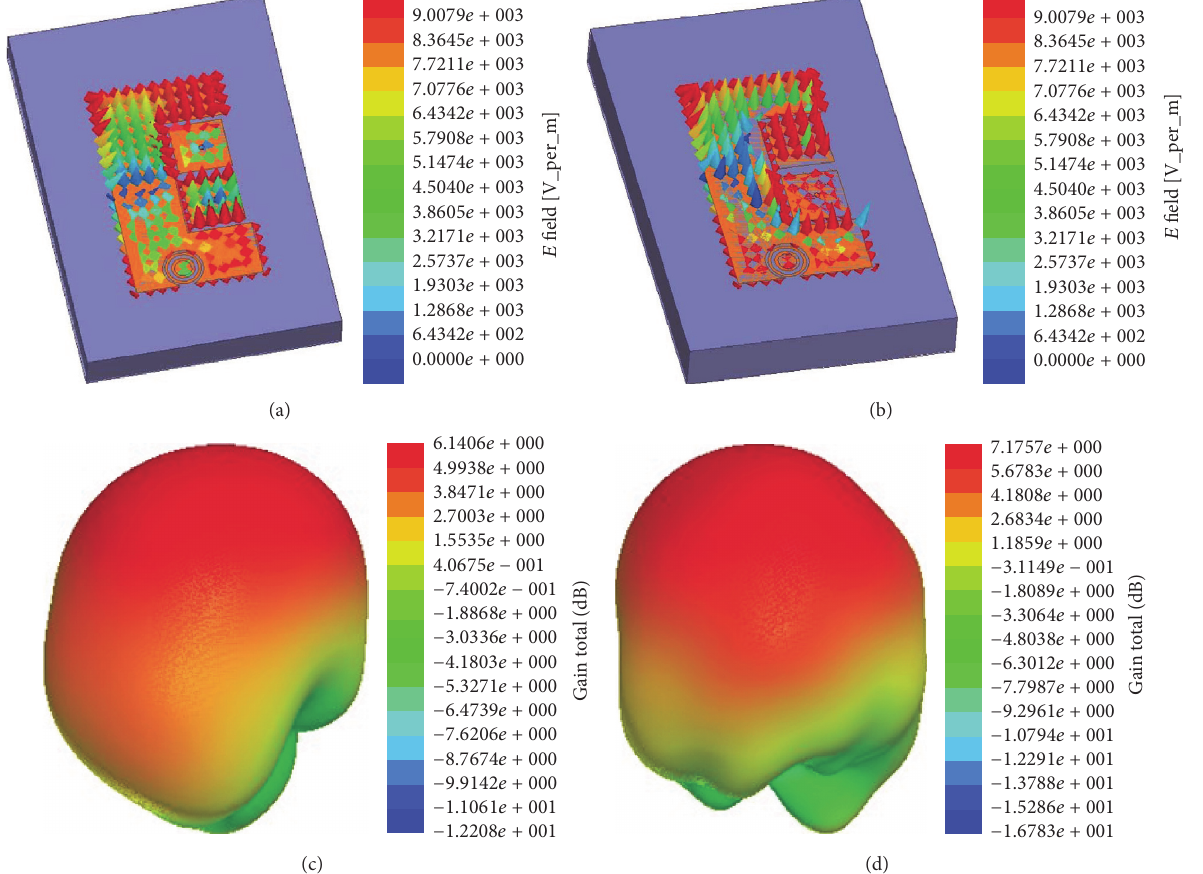
Figure 5: Simulated electric field distributions and 3D radiation patterns. Electric field distribution at (a) 3.5 GHz and (b) 5.25 GHz. 3D radiation patterns at (c) 3.5 GHz and (d) 5.25